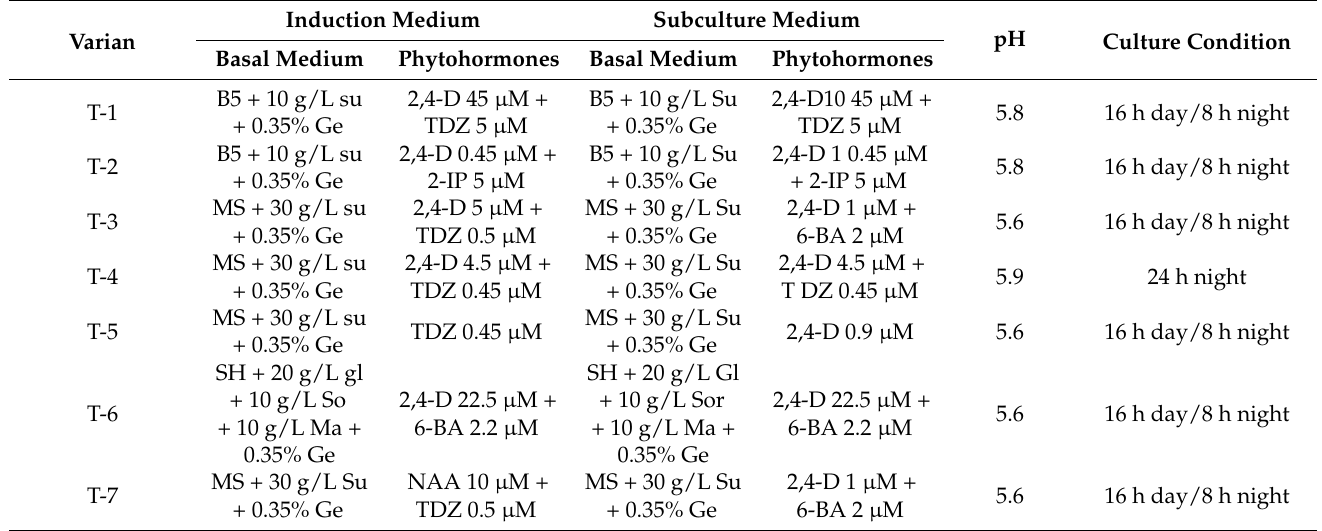
Table 1. The composition of callus induction